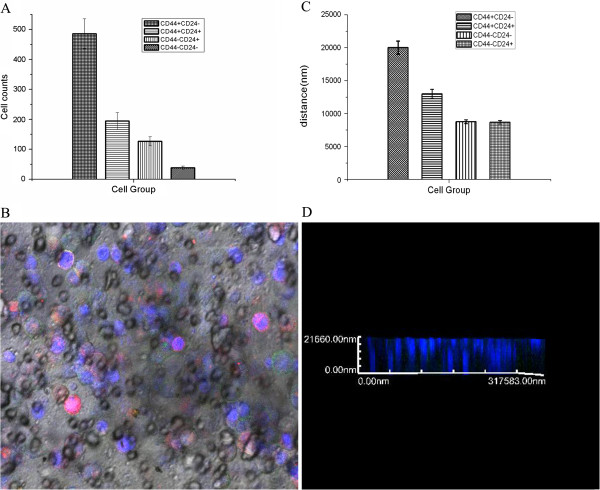
Invasion assay of these four subsets of MCF7 cells. A, Cell number quantification of invasion. B, Confocal images of these four subsets of MCF7 cells (Green: CD44+/CD24-/low; Red: CD44-/CD24+; Yellow: CD44+/CD24+; and Blue: CD44-/CD24-). C, Quantification of tumor cell migration distance. D, Images of cell migration distance.